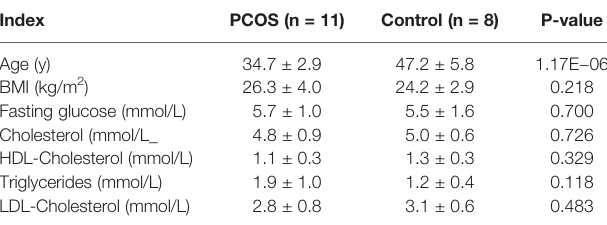
TABLE 1 | Clinical characteristics of PCOS patients and control